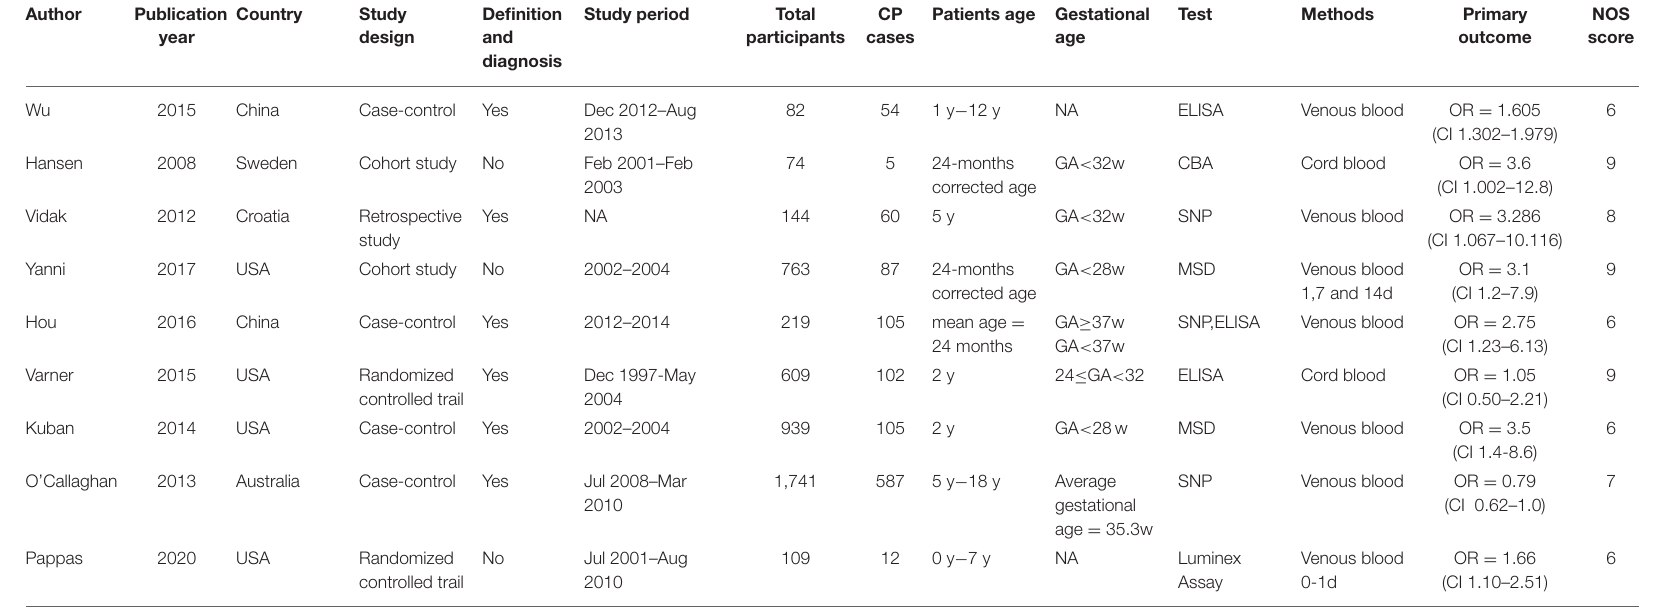
TABLE 1 | Characteristics of the included